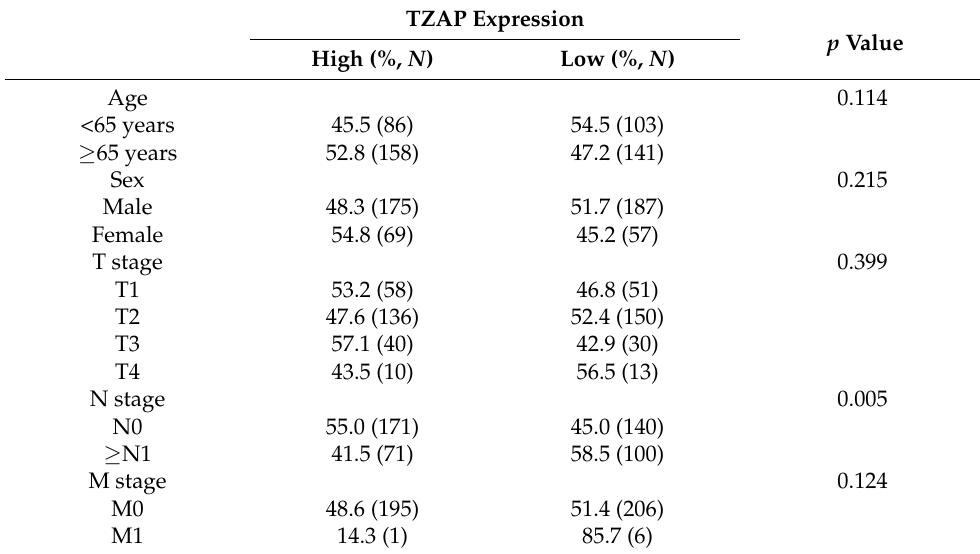
Table 2. Clinical characteristics of TZAP expression in lung squamous cell